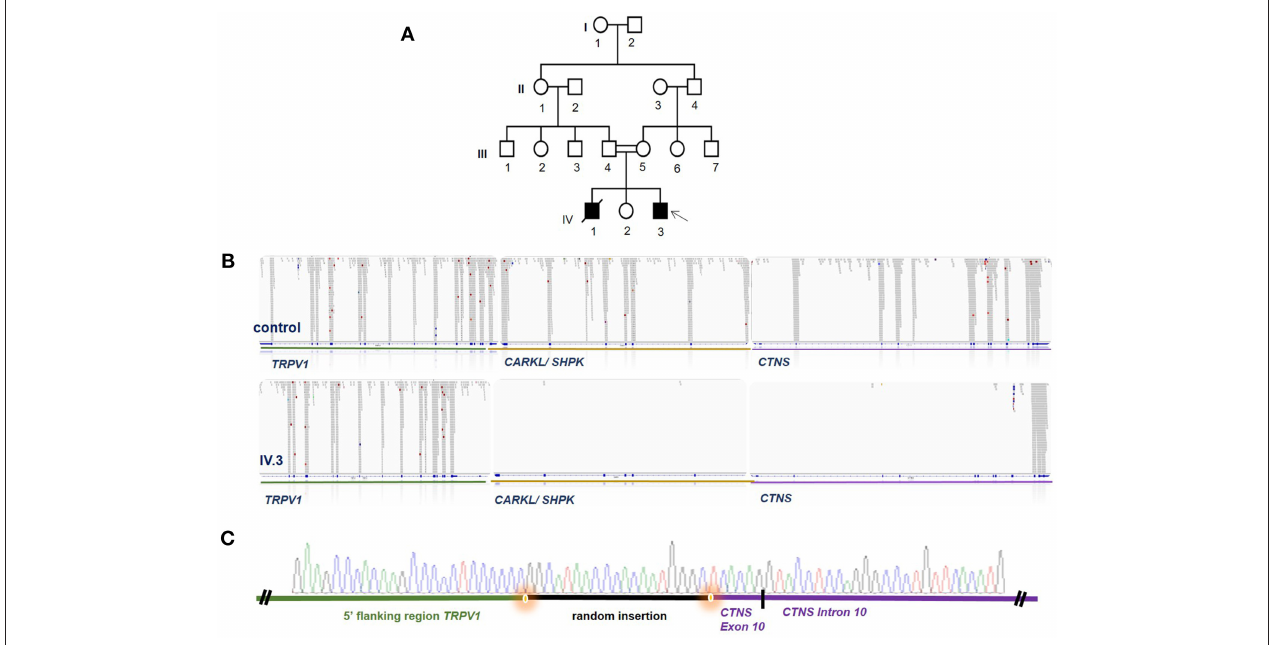
FIGURE 1 | WES identifies a homozygous deletion encompassing large parts of CTNS. (A) Pedigree of the Iranian family, DNA of individual IV3 was analyzed by WES (arrow) while no DNA of other family members was available. Females are marked with circle, males with square, solid filling marks affected individuals, crossed symbols marks a deceased individual, double lines between individuals mark a consang. marriage and single lines mark non-consang.-marriages. (B) WES revealed a large genomic deletion for individual IV.3 encompassing parts of TRPV1, all of CARKL/SHPK and large parts of CTNS as visualized in the BAM file generated from WES data. Read alignment of a control person is shown above for comparison. (C) Breakpoint confirmation by Sanger sequencing confirms presence of the homozygous deletion and reveals a random insertion shown in black.